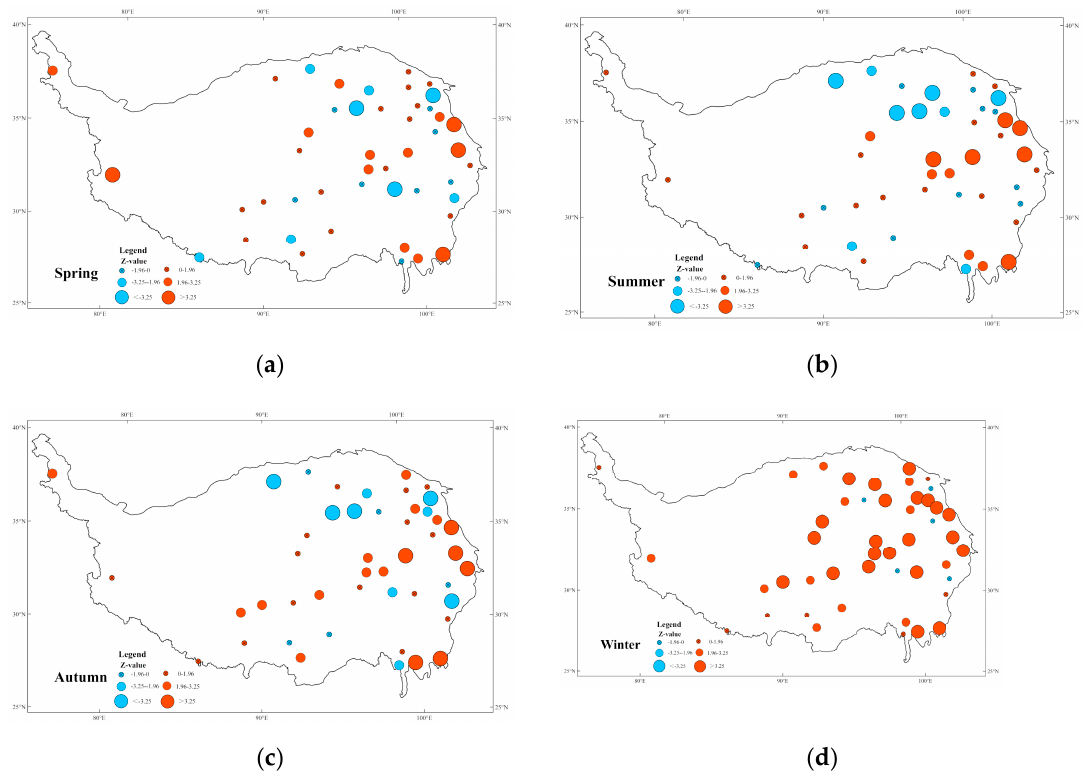
Figure 9. The distribution of the of the Mann–Kendall Z statistic for ET 0 series at each station of from 1961 to 2017, where ( a ) is spring; ( b ) is summer; ( c ) is autumn; ( d ) is winter. The significance level and expression method are the same as in Figure 7b.